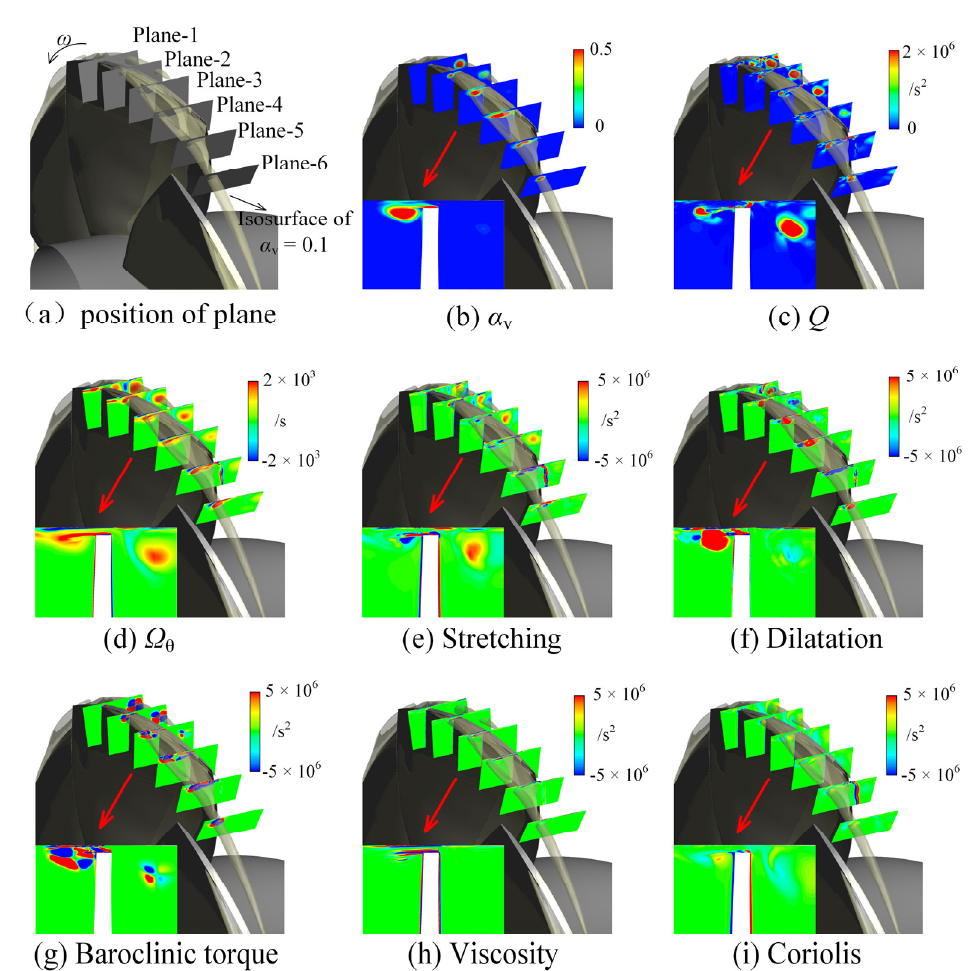
Figure 8. Location of the six planes and the predicted vapor volume fraction, Q criterion, relative vorticities, and the terms on the right side of the vorticity transport equation.